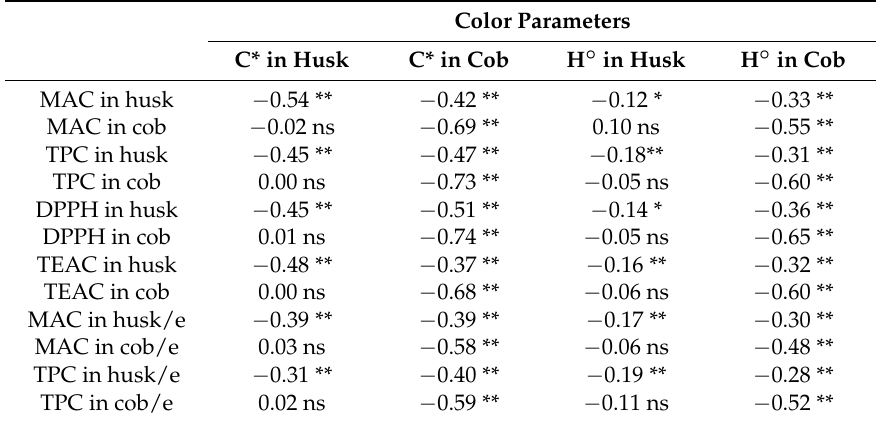
Table 5. Pearson correlation coefficients between color parameters, monomeric anthocyanin content, total phenolic content, and antioxidant activities of 1–47 genotypes in husk and